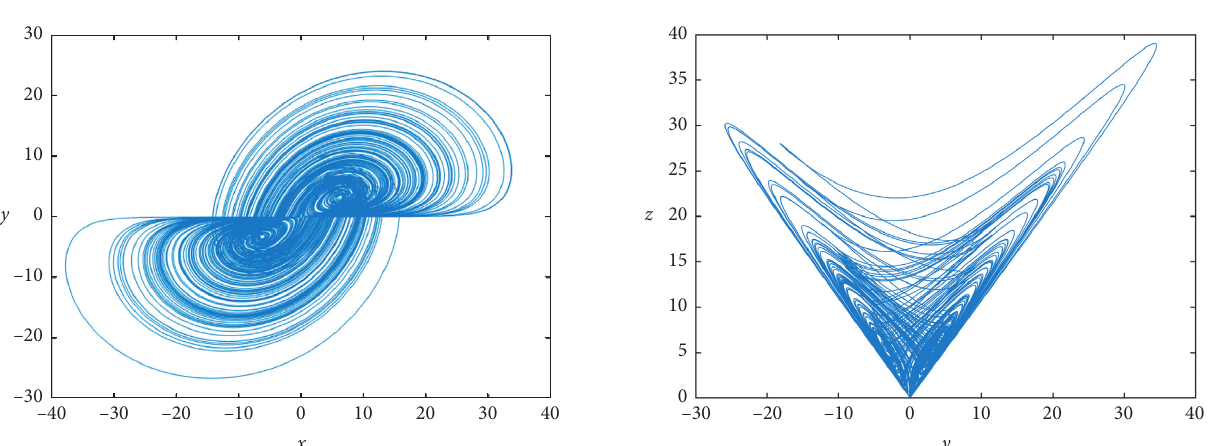
Figure 4: Dynamics of Lu et al.’s fractional-order system in (13)–(15) with the order α � 0 . 92, in context of x and y directions.